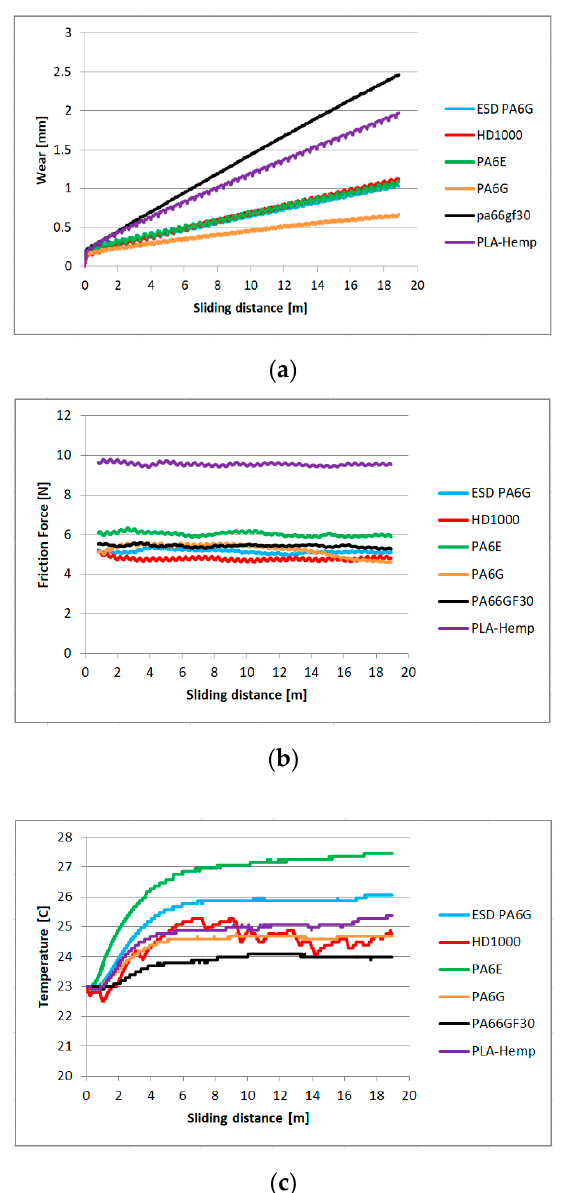
Figure A1. The wear ( a ), abrasive friction force ( b ) and temperature ( c ) of the tested polymers on P60 abrasive clothing with the lowest applied pv (Table 1).